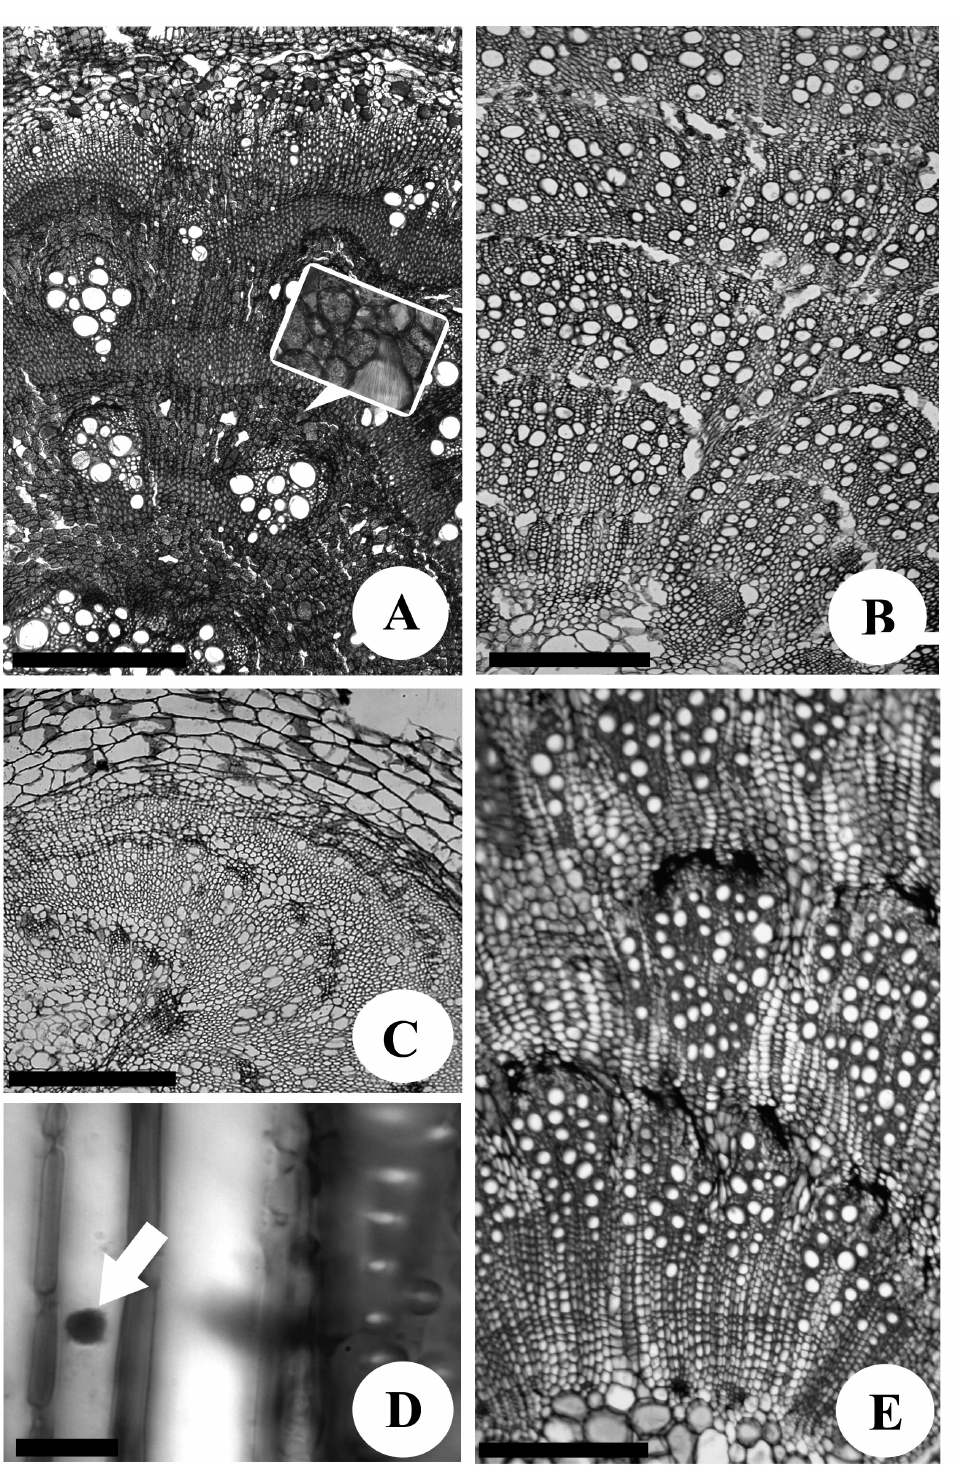
FIGURE 4 - Transverse view (A-C, E) and longitudinal (D) view of root of Boerhaavia diffusa, Trianthema portulacastrum and Sesuvium portulacastrum. A. Root portion of Boerhaavia diffusa L. Enlarge area showing raphides and starch grains accumulation in parenchymatous cells. B. Matured stem of Trianthema Portulacastrum L. showing incomplete successive rings of cambia, arrow showing druses present in ground parenchymatous region. C. Trianthema portulacastrum L. root showing more number of continuous successive cambial rings. D. Xylem fibre with a nucleus (arrow). E. Mature stem Sessuvium portulacastrum showing successive rings of xylem embedded in parenchymatous groundmass of conjunctive